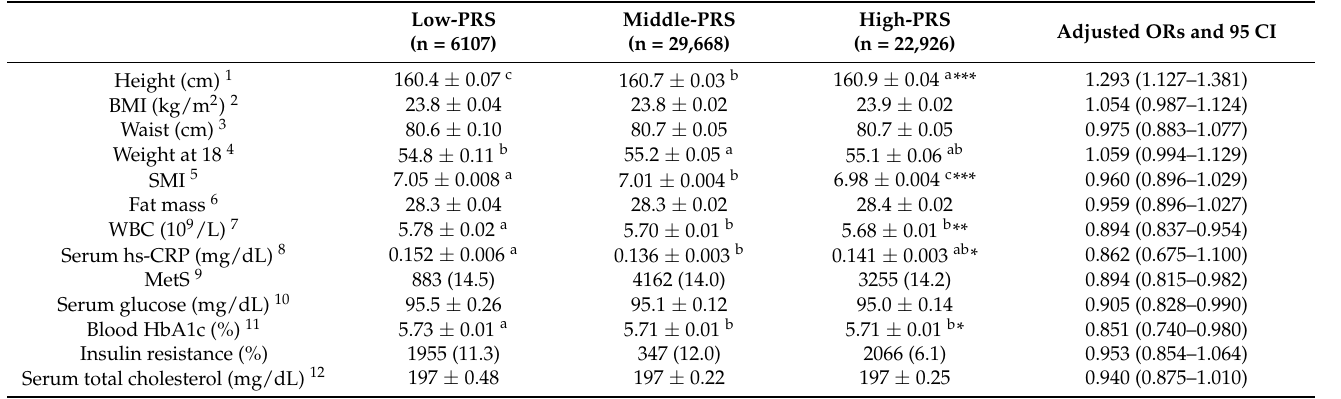
Table 5. Adjusted means and odds ratio (ORs) of metabolic syndrome (metS)-related parameters according to polygenic risk score (PRS) of the four-SNP model generated from adult height. Low-PRS (n =